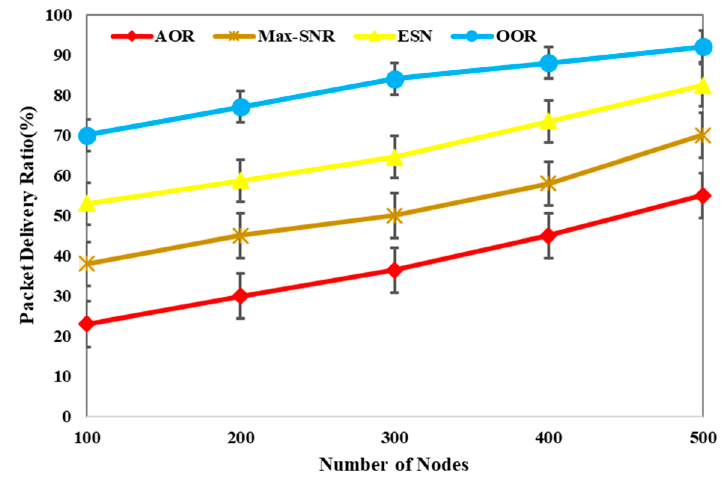
Figure 6. Packet delivery ratio comparison with varying number of nodes.